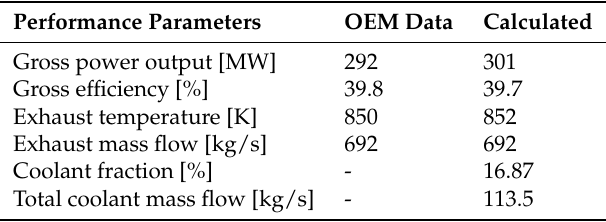
Table 4. General simulation results and validation.